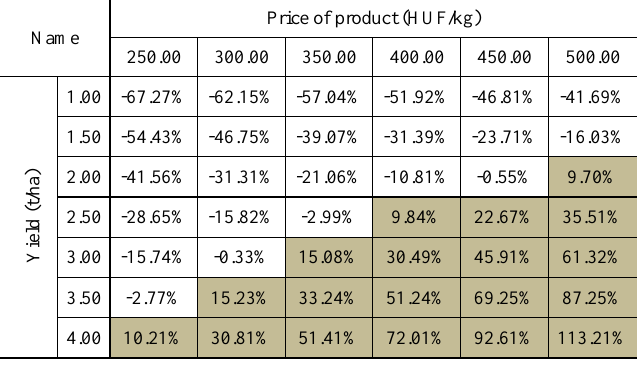
Table 9. Cost related profitability of the production of raw walnut as a function of average price and yield